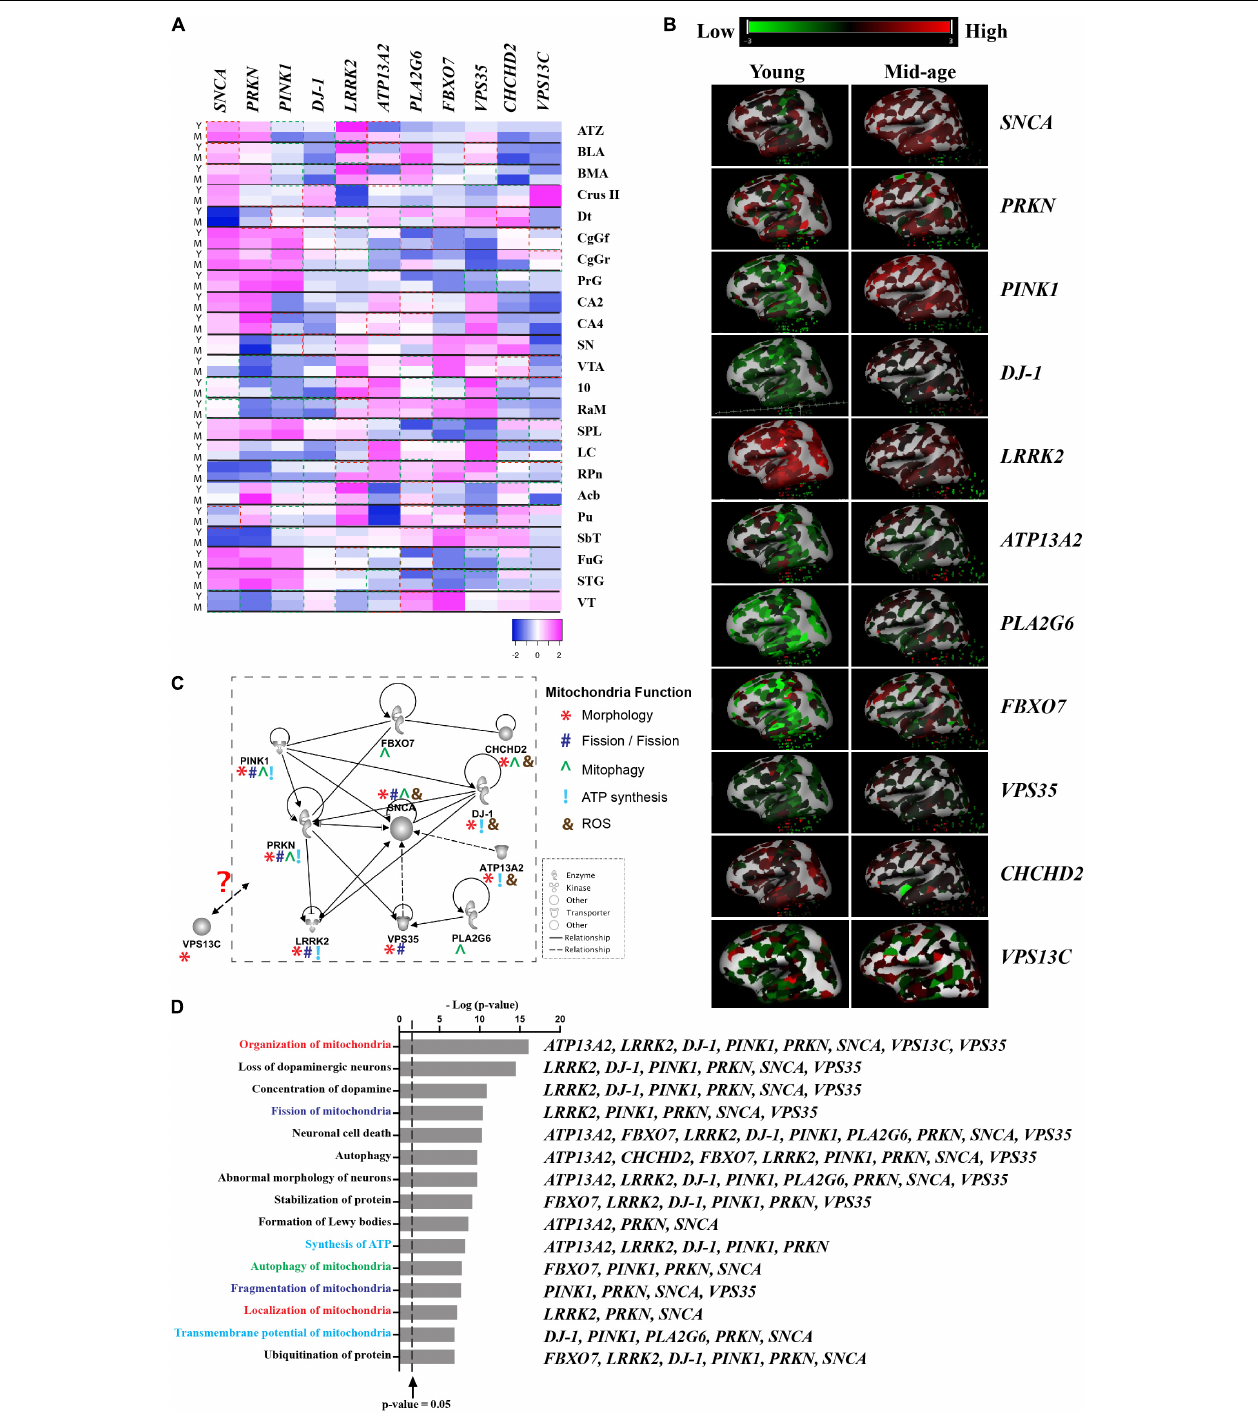
FIGURE 1 | Interaction of proteins encoded by mitochondrial-related PARK genes. (A) Gene expression data was obtained from Allen Brain Atlas, Allen Institute. n = 2–3/group. Y-Young (age of 24, 31, and 39), M-Middle age (age of 49, 55, and 57). Heatmap showing the z-score was generated using online Heatmap program (Babicki et al., 2016). Red boxes indicates up-regulated gene expression with a fold change of greater or equal to 2 (M vs Y) and green boxes indicates down-regulated genes expression with a fold change of greater or equal to 2 (M vs Y). (B) 3D heatmap of the 11 genes from Allen Brain Atlas, Allen Institute. Young (age of 24) and mid-age (age of 57); (C) The interactive pathways of proteins encoded by the 11 PARK genes generated from IPA (Ingenuity Systems Inc., Redwood city, CA, United States). Symbols are used to show mitochondrial function: *Morphology; # Fission/Fusion; ˆMitophagy; ! ATP synthesis; and & ROS. (D) Top 35